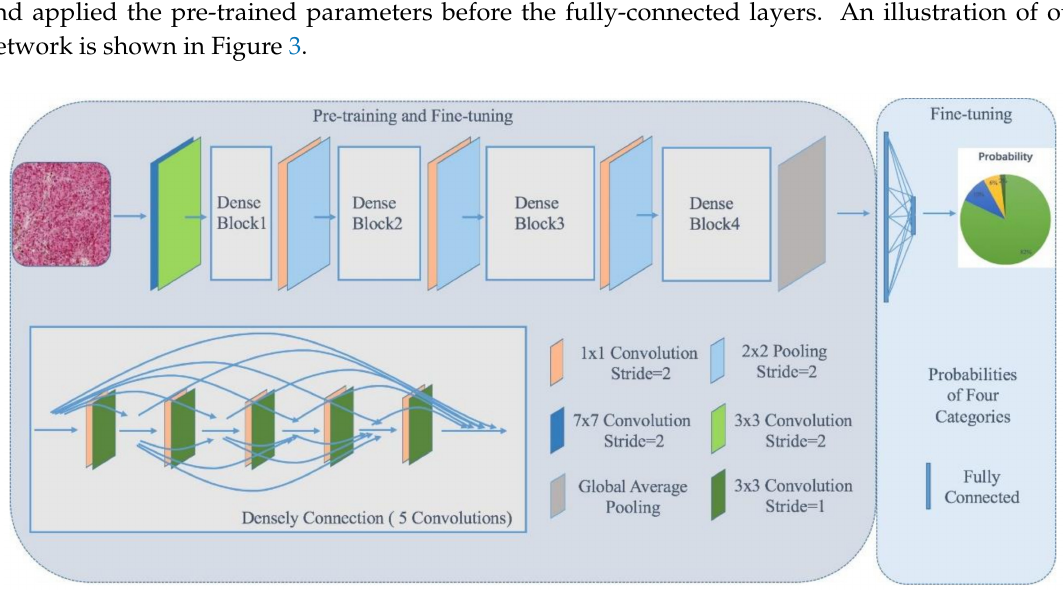
Figure 3. Illustration of our densely-connected deep network. We employed the DenseNet-121 based network in which there are four dense blocks. These four dense blocks are composed by densely-connected cascaded convolutional operations with di ff erent groups of convolutions with the number of 6, 12, 24, 16, as shown in the left bottom. The dense connection is shown by five convolutional groups. Each group of convolutions is composed of one 1 × 1 convolutional layer and one 3 × 3 convolutional layer. All of the dense blocks are connected by one 1 × 1 convolutional layer and one 2 × 2 pooling